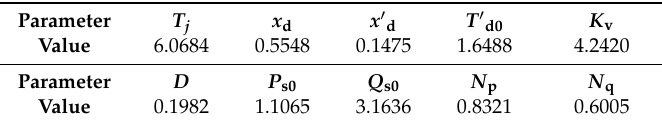
Table 6. Parameters of equivalent model